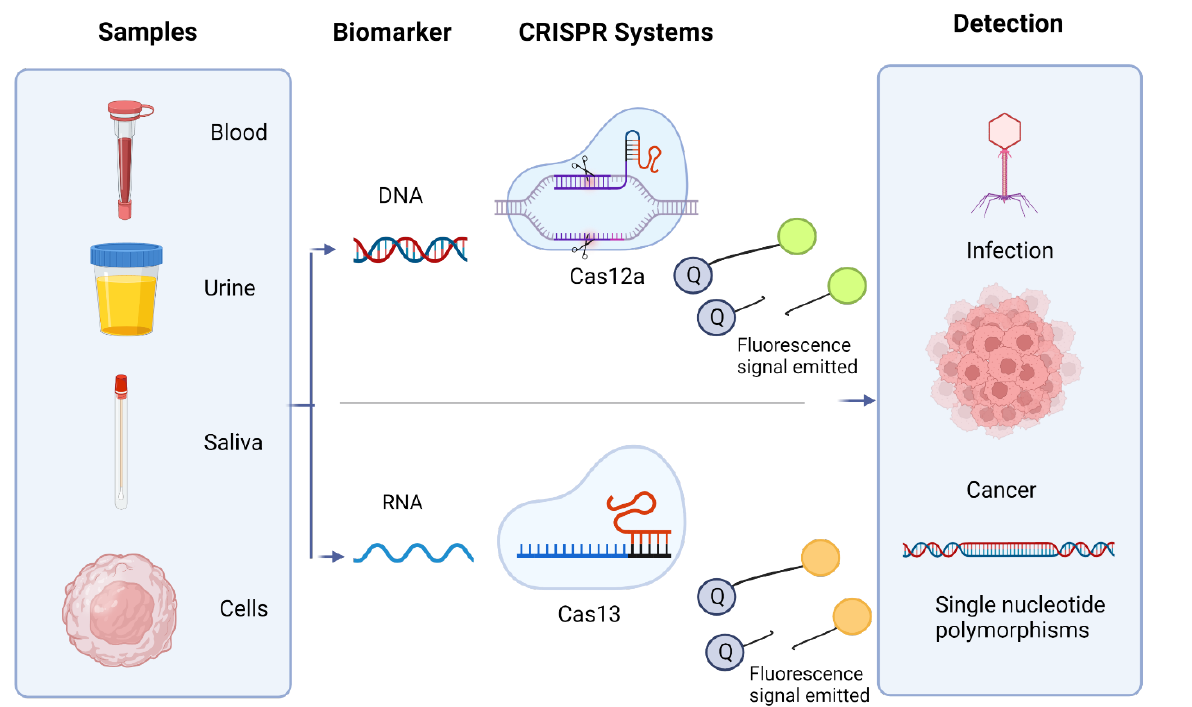
Figure 4. The use of CRISPR/Cas12 and Cas13 for detection of tropical diseases. (Adapted from Ref. [92] with free permission. Created with BioRender.com accessed on 21 September 2022).